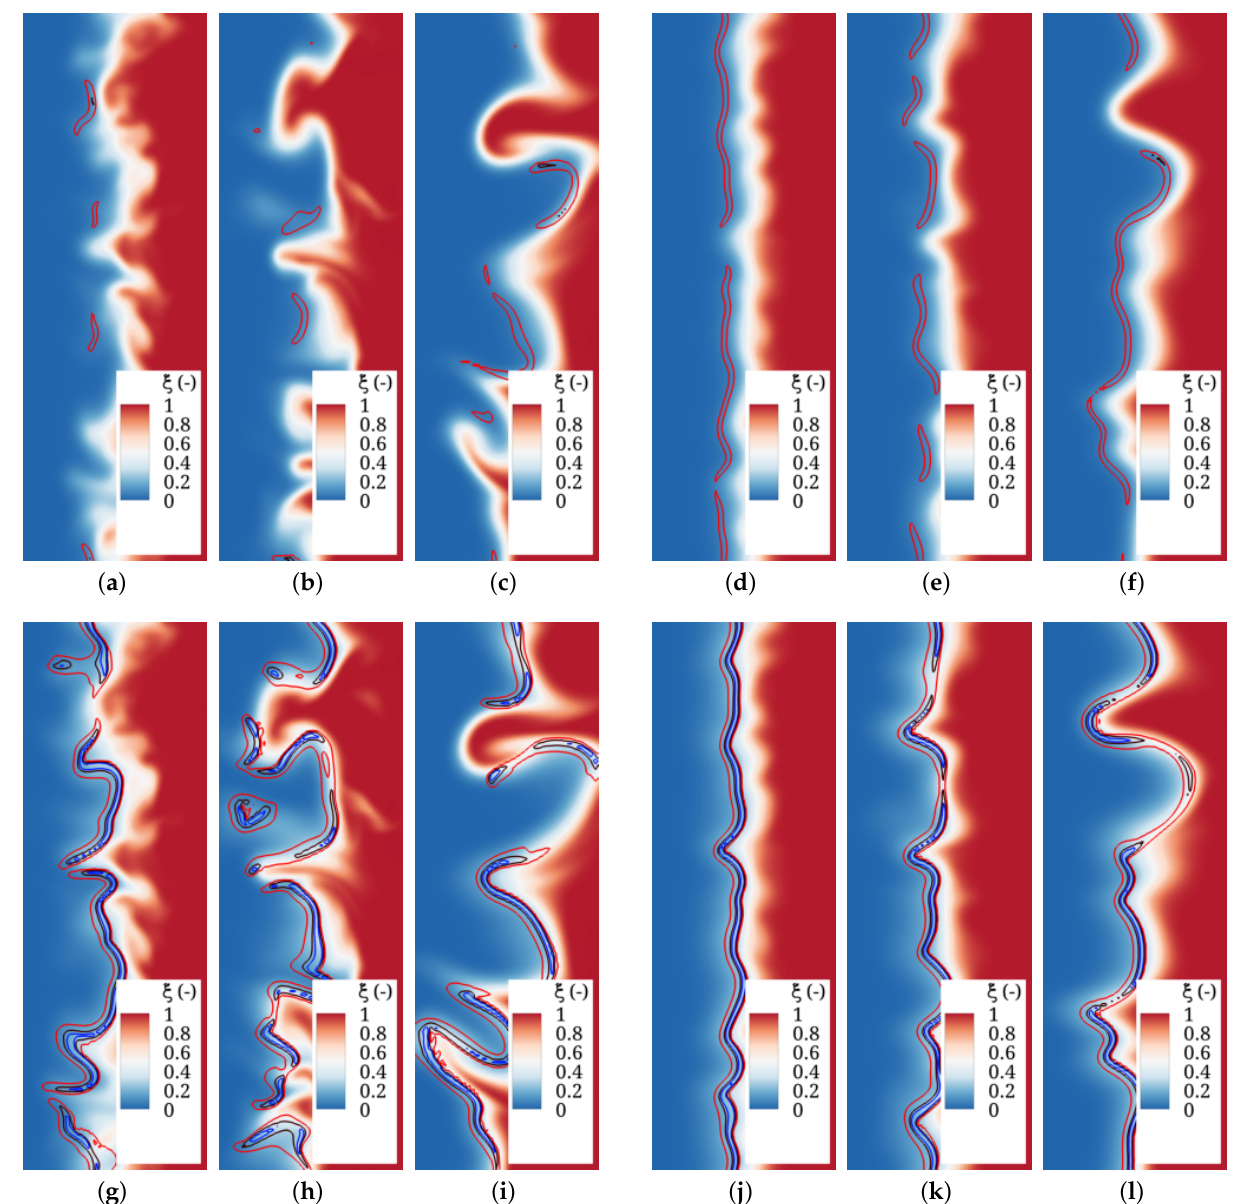
Figure 11. Mixture fraction contours at the ‘y–x’ cross-section along with the iso-lines of heat release (red—2000 MJm − 3 s − 1